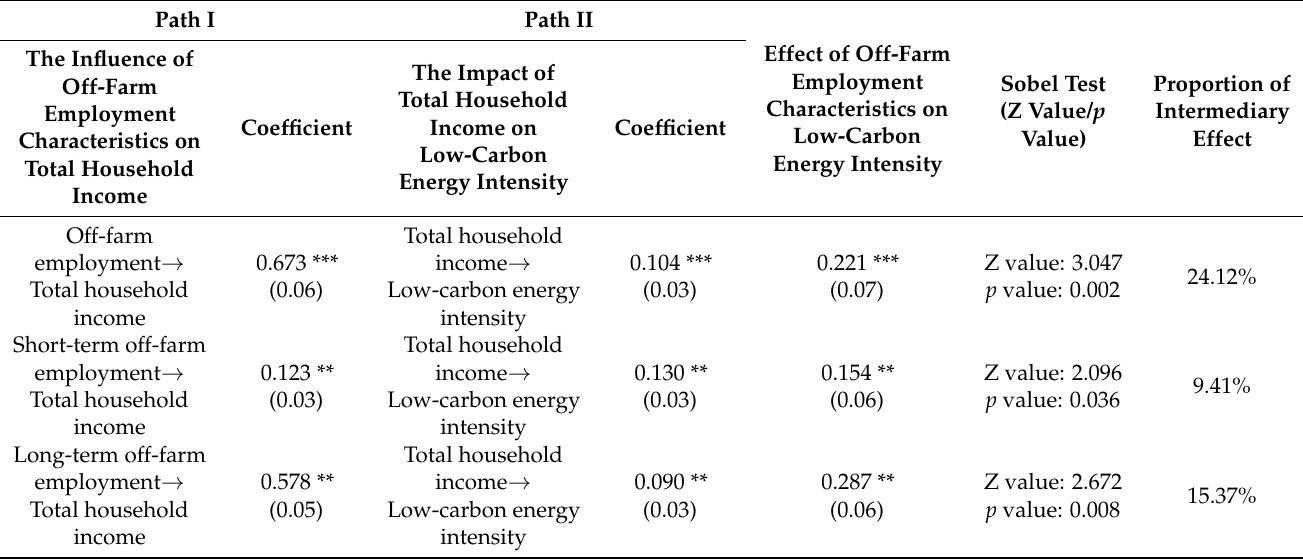
Table 4. Mediation test of income effect (N = 1351).